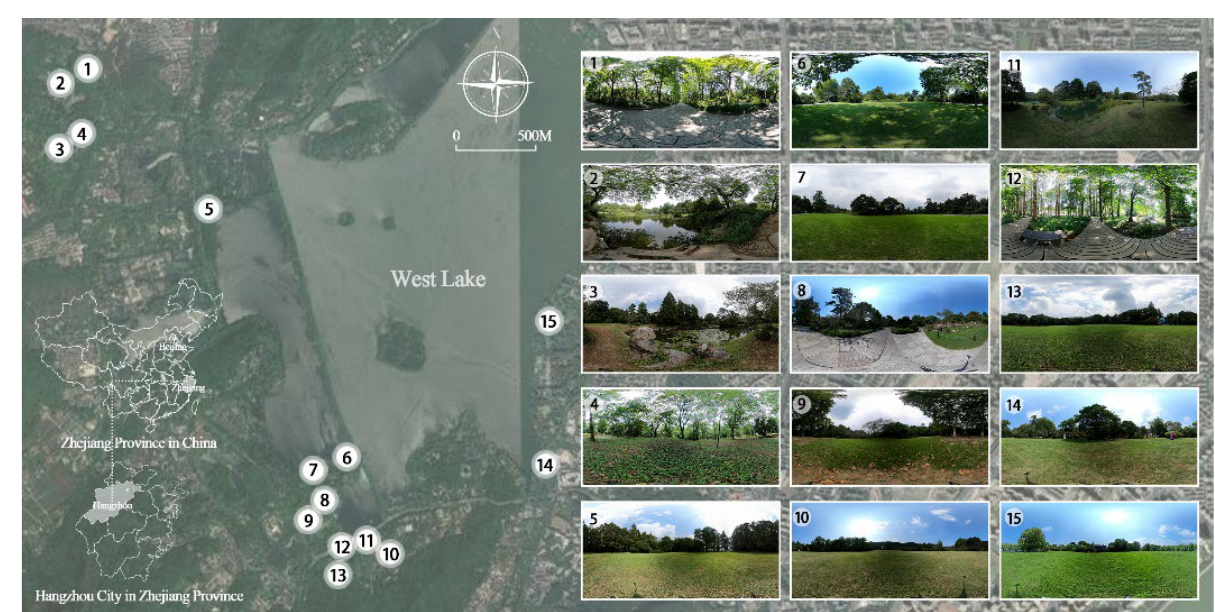
Figure 1. The locations and 360° panoramic photos of the 15 study sites in Hangzhou, China.